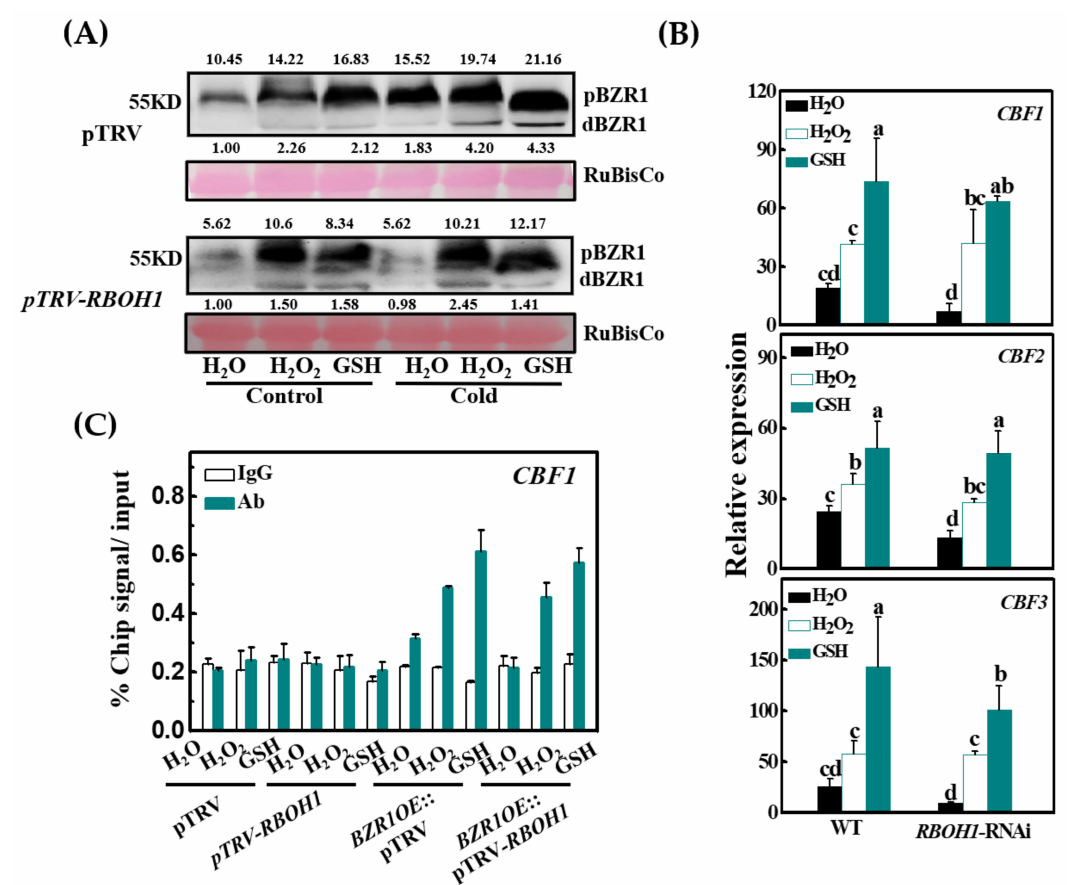
Figure 6. H 2 O 2 and GSH treatment rescue the accumulation of BZR1 protein and the transcript levels of CBF genes in RBOH1 -silenced plants. ( A ) The accumulation of BZR1 proteins in pTRV and pTRV- RBOH1 plants under control (25 ◦ C) and cold (8 ◦ C) conditions. Plants were foliar applied with distilled water, 5 mM H 2 O 2 , and 5 mM GSH, respectively, for 12 h and subsequently exposed to 8 ◦ C for another 12 h, and 35S:BZR1 -3HA-overexpressing ( BZR1 :OE) plants were used for VIGS. The value above and below each lane indicates the relative accumulation of pBZR1 and dBZR1, respectively. ( B ) The relative expression levels of CBF genes in wild-type (WT) and RBOH1 -RNAi plants after exposure to cold at 8 ◦ C for 8 h. Moreover, 12 h before cold treatment, plants were foliar applied with distilled water, 5 mM H 2 O 2 , or 5 mM GSH, respectively. ( C ) ChIP-qPCR analysis showing DNA-binding activity of BZR1 enhanced by H 2 O 2 and GSH treatment in tomato leaves. ChIP was performed with BZR1 :OE (pTRV and pTRV- RBOH1 ) plants foliar applied with H 2 O, 5 mM H 2 O 2 , or 5 mM GSH for 12 h. CBF1 promoter fragments were immunoprecipitated with an anti-HA antibody. Mouse IgG was used in control reactions. Input- and ChIP-DNA samples were quantified by qRT-PCR. The ChIP data are shown as % input DNA. Data are the means of three biological replicates ( ± SD) shown by vertical error bars. Different letters indicate significant differences according to Tukey’s test at 0.05% level. VIGS, virus-induced gene